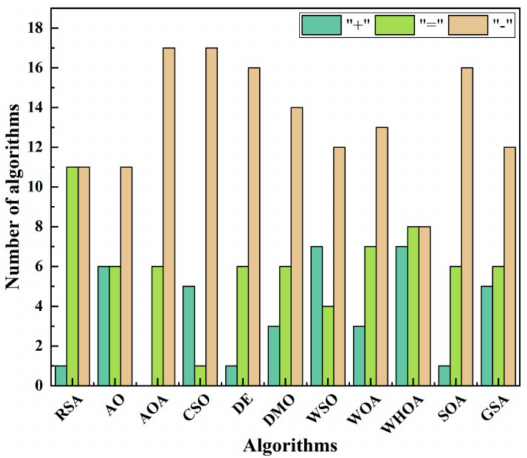
Figure 6. The number of better than, worse than, same as